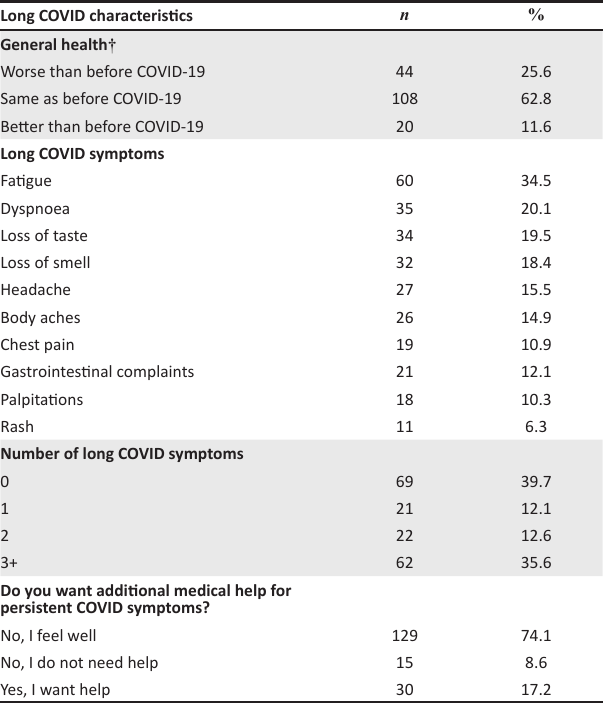
TABLE 3: Long COVID characteristics. Long COVID